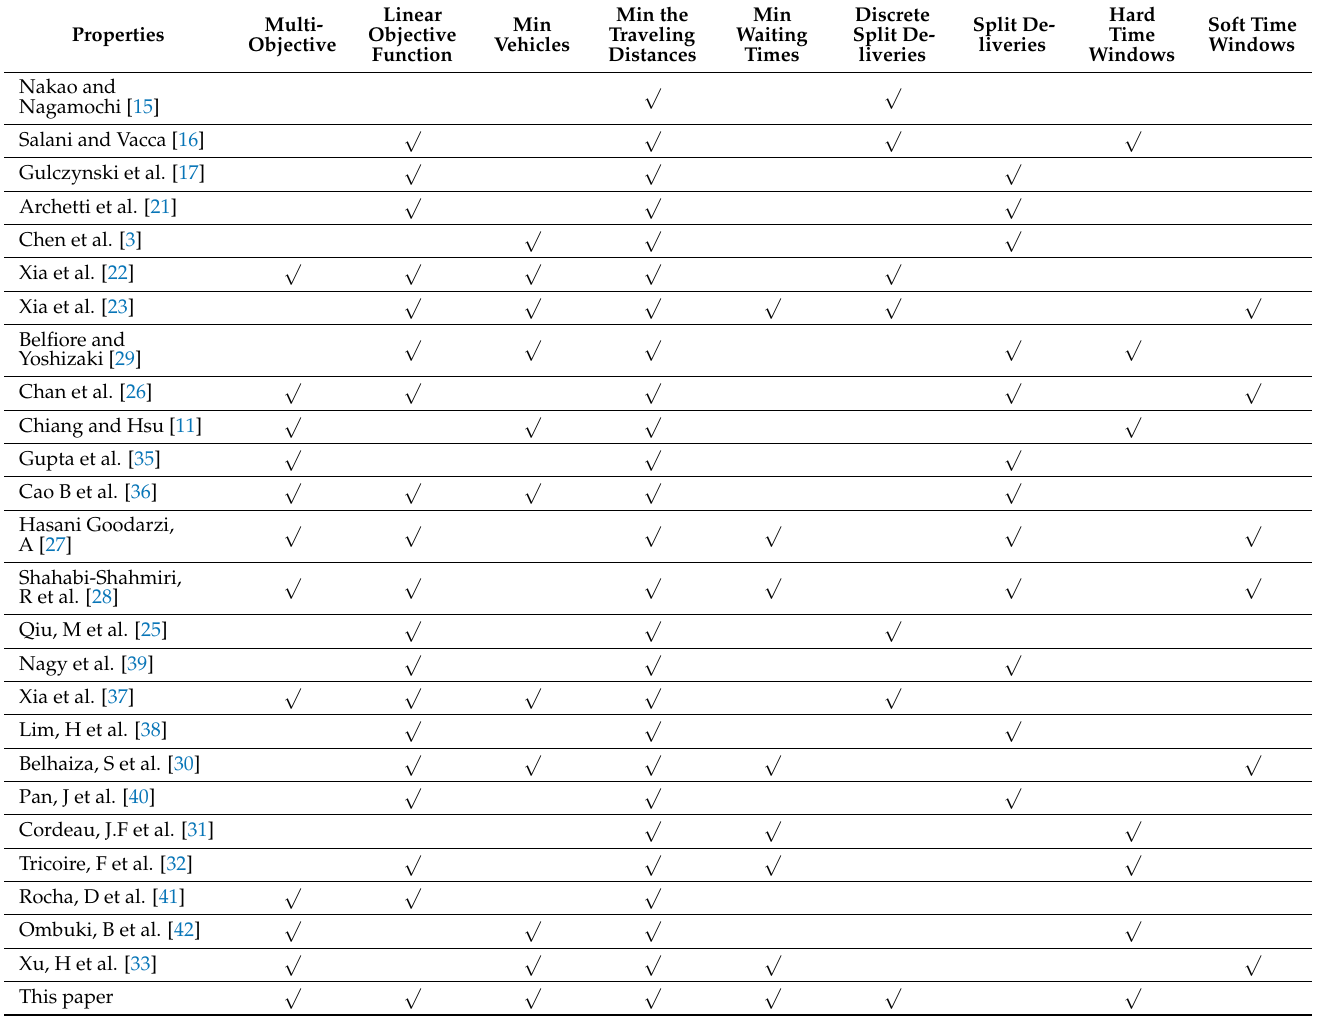
Table 1. Comparative analysis with existing